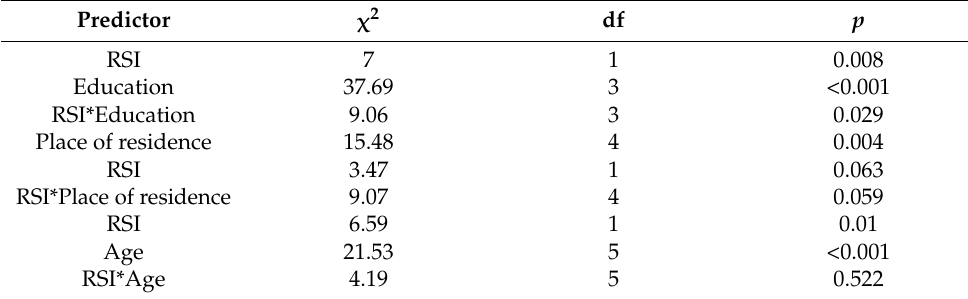
Table 7. Omnibus Likelihood Ratio Tests.